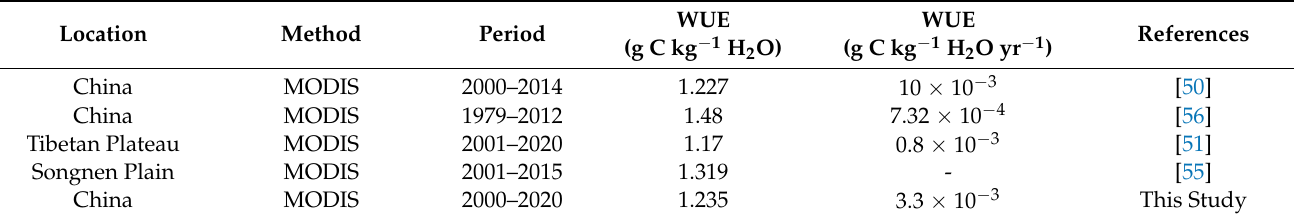
Table 4. Mean values and trends of CUE by